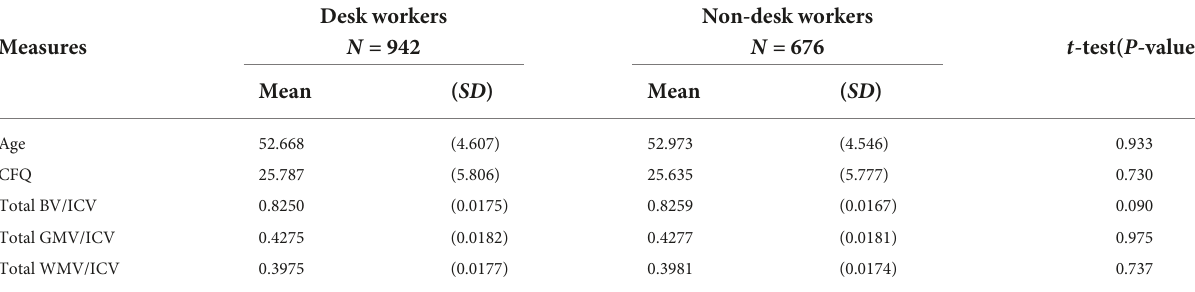
TABLE 1 Differences in age, CFQ score, and several brain region volumes (divided and standardized by intracranial volume) between work type groups. Desk